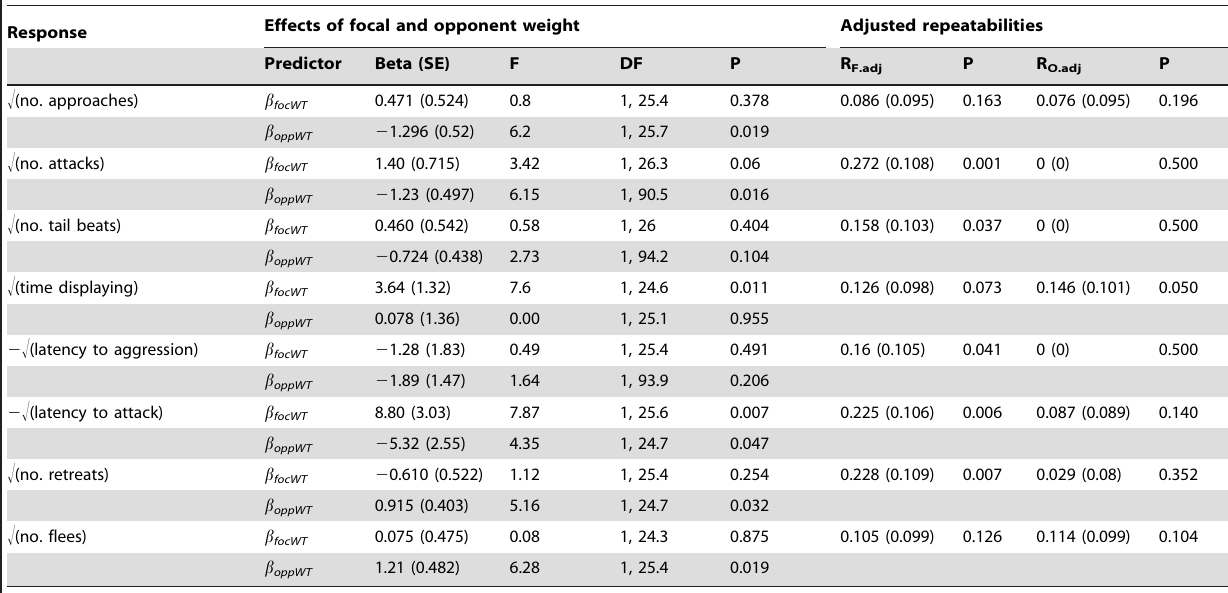
Table 5. Effect of absolute focal and opponent weights on focal behaviours in dyadic trials.